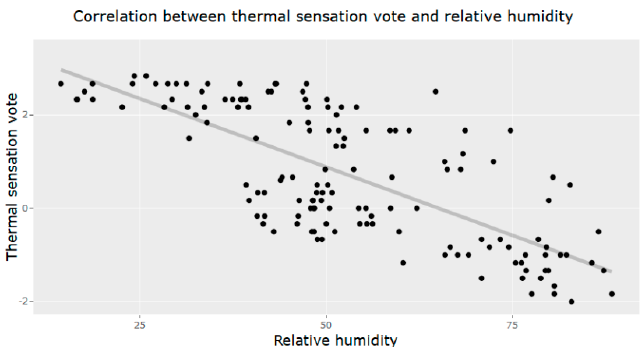
Figure 7. Correlation between the pedestrians’ thermal sensation votes and mean relative air humidity in the two analysis periods (January and July 2016).